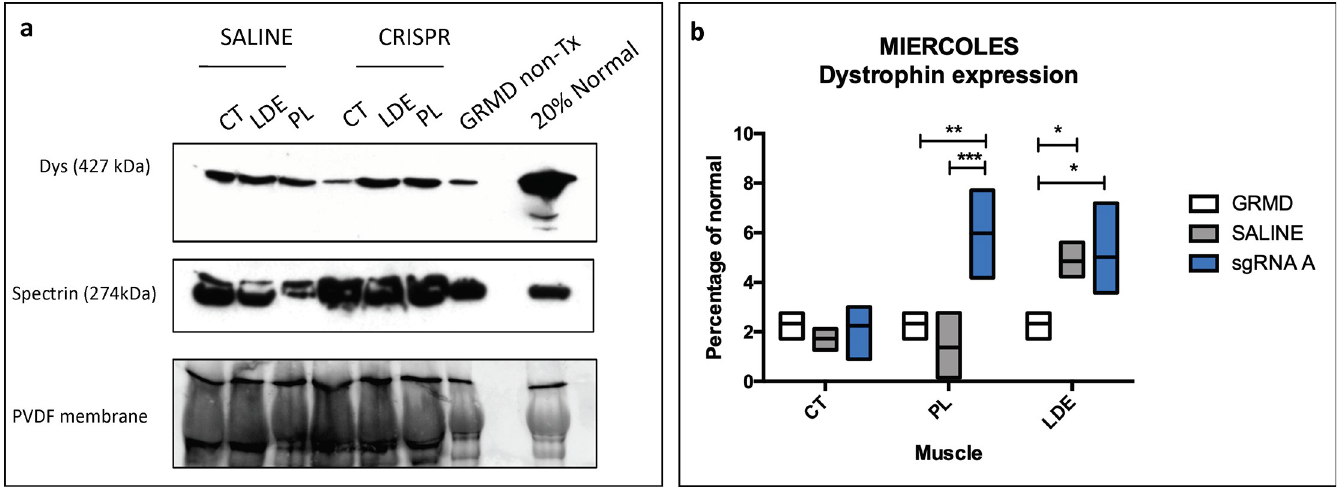
Fig 5. Dystrophin protein expression after HDR-CRISPR treatment in Miercoles. CRISPR sgRNA A was injected into one cranial tibial compartment and saline into the other. The vastus lateralis muscle from Miercoles (GRMD) was biopsied before injections to provide a general baseline and the HDR-CRISPR/saline muscles were harvested 3 months after treatment. (a) Dystrophin co-stained with C and N-terminus antibodies with goat anti-mouse secondary staining, β -spectrin stained as a muscle marker with goat anti rabbit secondary staining. Total protein from the PVDF membrane was used to normalize dystrophin. Normal sample was diluted to 20%. (b ) Graph with dystrophin quantification for each muscle in the cranial tibial compartment. The PL and LDE muscles had increased dystrophin restoration in the HDR-CRISPR-Tx muscle compared to saline and GRMD while there were no differences in the HDR-CRISPR-Tx CT muscle. Statistical analysis was performed